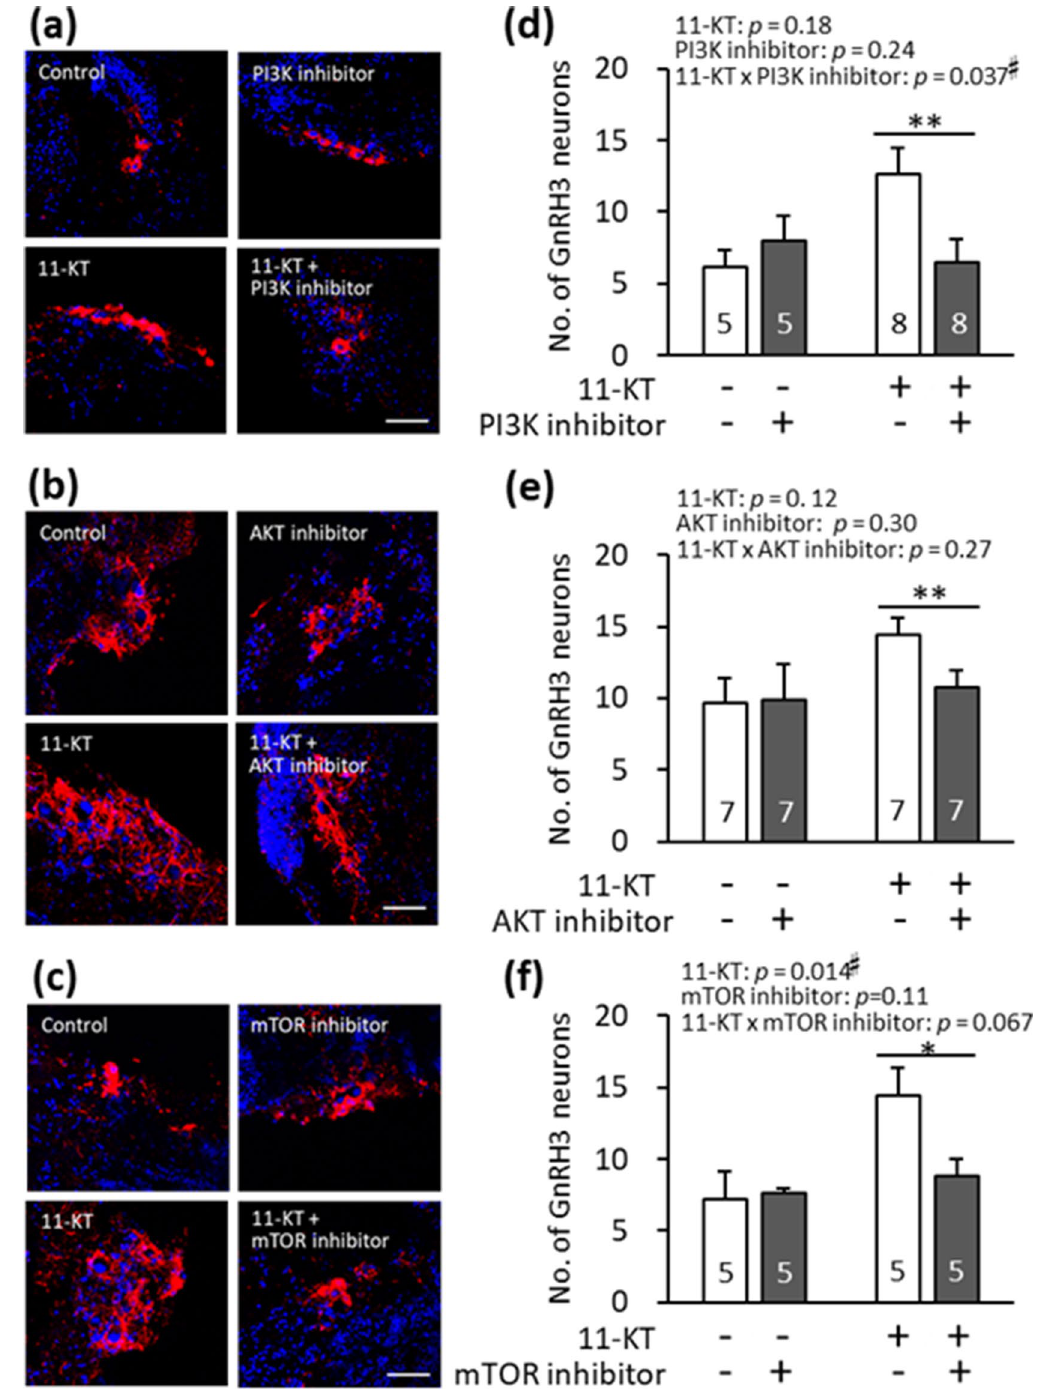
Figure 7. ( a )–( c ) Representative images of gonadotropin-releasing hormone 3 (GnRH3) neurons (red) in the following four groups of brain slices: control, inhibitor-treated, 11-ketotestosterone (11-KT)-treated (10 nM), and 11-KT- (10 nM) and inhibitor-treated groups. Cell nuclei (blue) were stained with Hoechst 33342. ( d )–( f ) The numbers of GnRH3 neurons in the four groups. Control and inhibitor-treated slices originated from the same animals, while 11-KT-treated slices and 11-KT and inhibitor-treated slices originated from the same animals. Inhibitors used in ( a )–( c ) and ( d )–( f ) were as follows: ( a , d ) phosphoinositide 3-kinase (PI3K) inhibitor (LY294002), (b, e) AKT inhibitor (GDC-0068), ( c , f ) mechanistic target of rapamycin (mTOR) inhibitor (rapamycin). Results from two-way analysis of variance (ANOVA) are shown in the top. Numerals in bars indicate the numbers of animals used for preparing slices. # , a significant difference at p < 0.05 (two-way ANOVA). * and **, a significant difference at p < 0.025 and p < 0.005, respectively [paired t -test, Bonferroni Correction (α new = α original / n = 0.05/2 and 0.01/2]. Data are expressed as the mean ± standard error of the